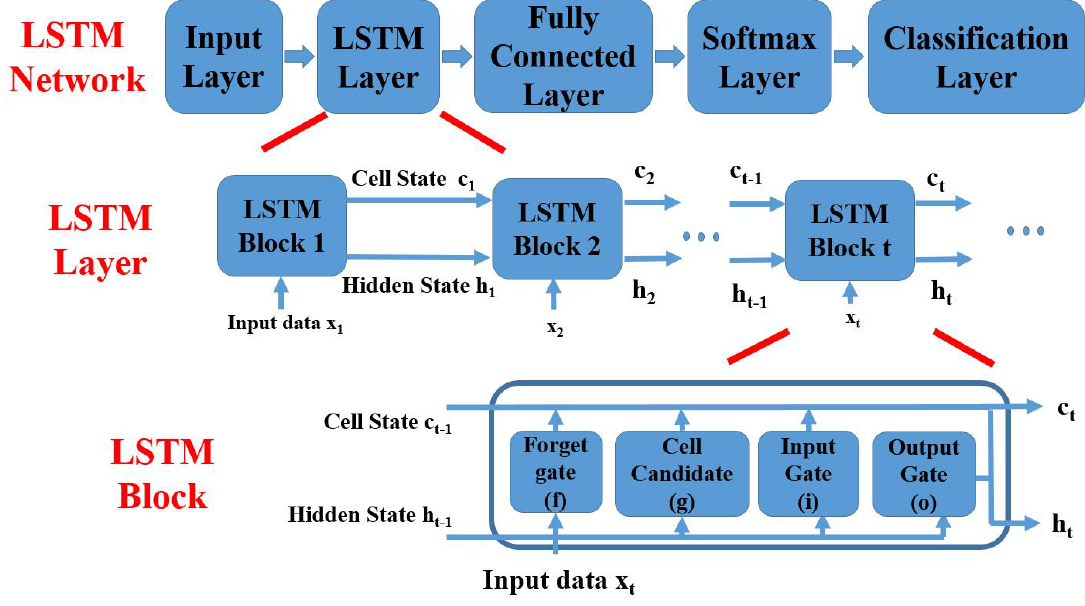
Figure 1. The long short-term memory (LSTM) network used in the proposed boosting method.